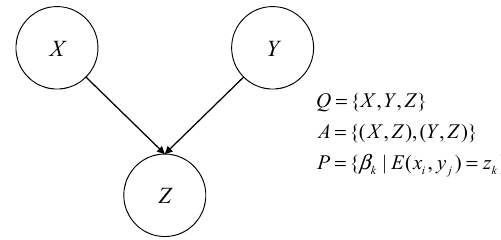
Figure 1. Basic evidence network diagram.